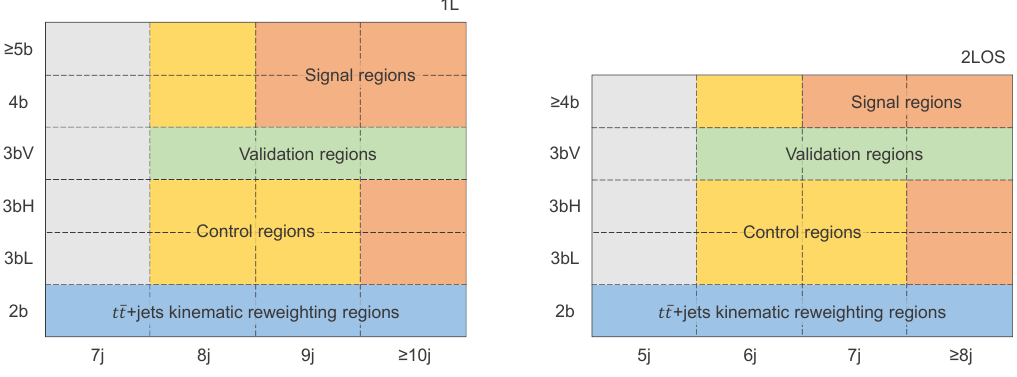
Figure 2 . Schematic view of the event categories used to select analysis regions (signal, control, validation and tt+jets reweighting regions) in the 1L channel (left) and 2LOS channel (right). The axes represent the jet multiplicity and b -tagging requirements defined in table 1. The 3bL (3bH) b -tagging requirement selects events with lower (higher) purity of MC ‘truth’ b -jets amongst the three jets tagged at the 70% OP. The 3bV b -tagging requirement is used to define the validation regions. The regions in grey are not used in the